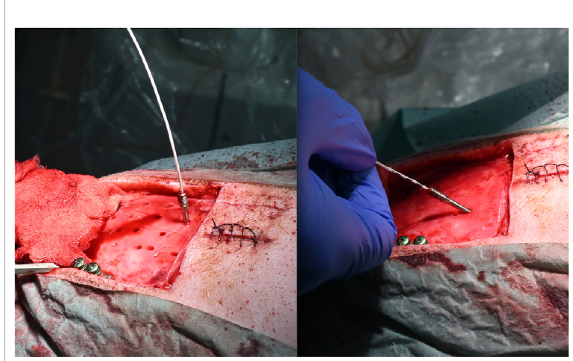
FIGURE 3 Possible different angulations. (A) Anchor bolt planned at 90 ° with inserted electrode and (B) anchor bold planned at 60 ° with inserted